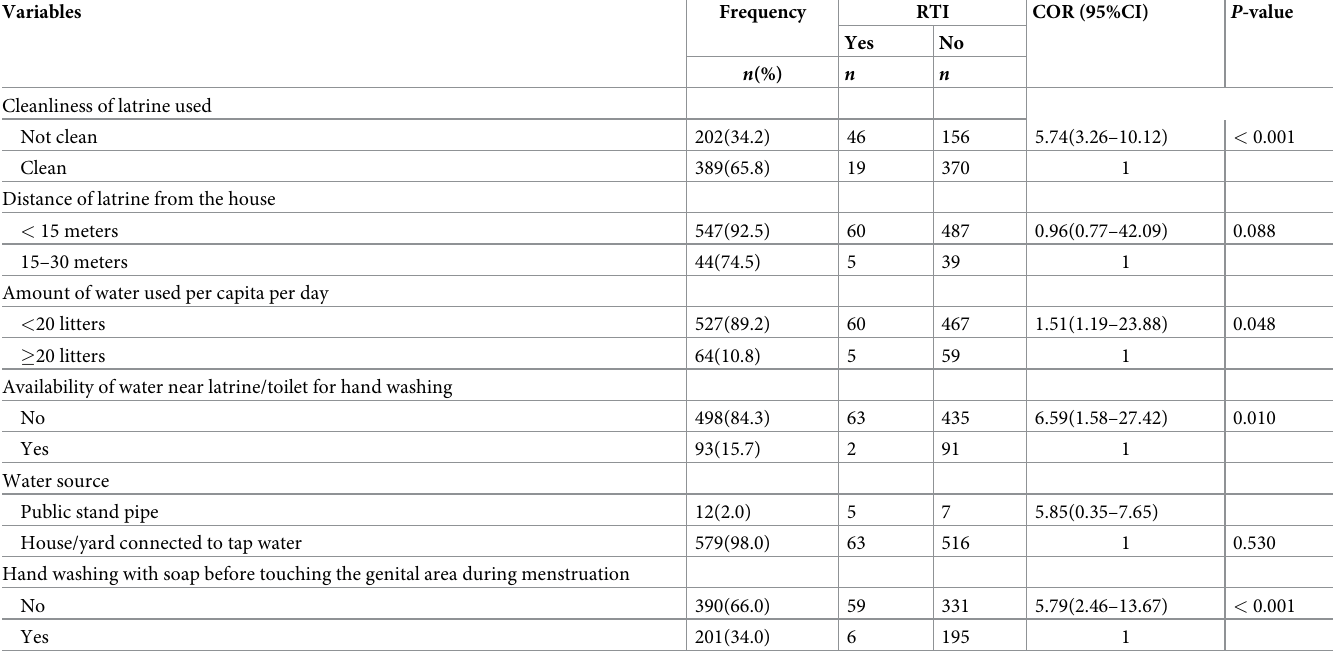
Table 2. Water, sanitation, and hygiene-related characteristics among the study participants in Dessie City, Ethiopia, January to March 2019. Variables